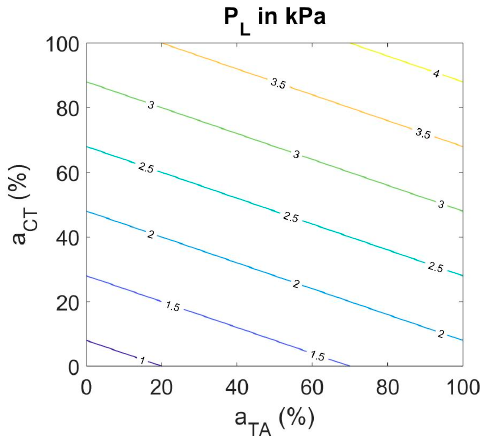
Figure 3. Muscle activation plot with lung pressure as the contour parameter.